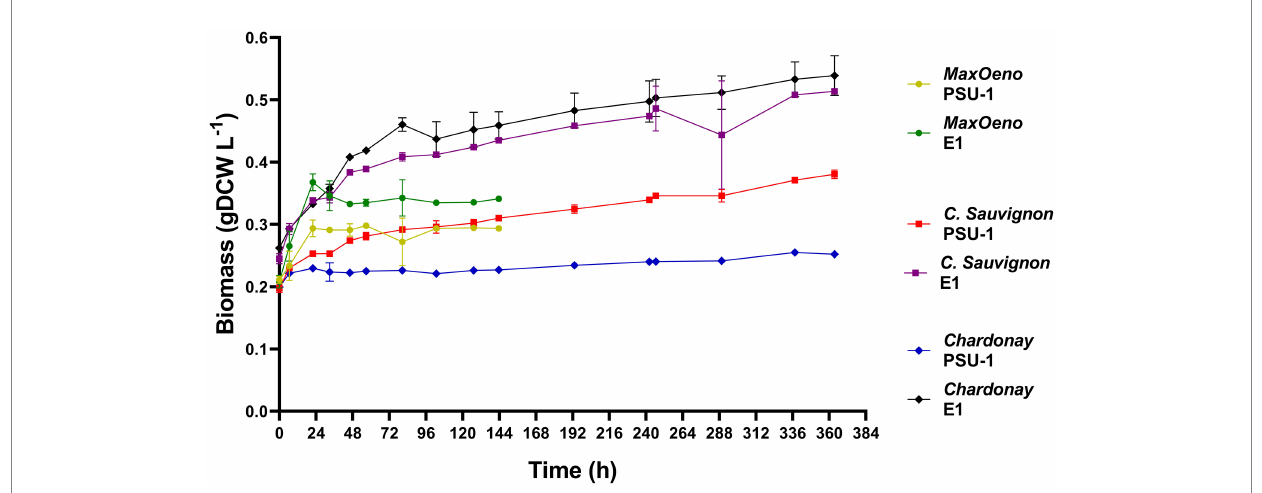
FIGURE 2 Evaluation of the growth of the PSU-1 and the E1 strains in different types of wine.